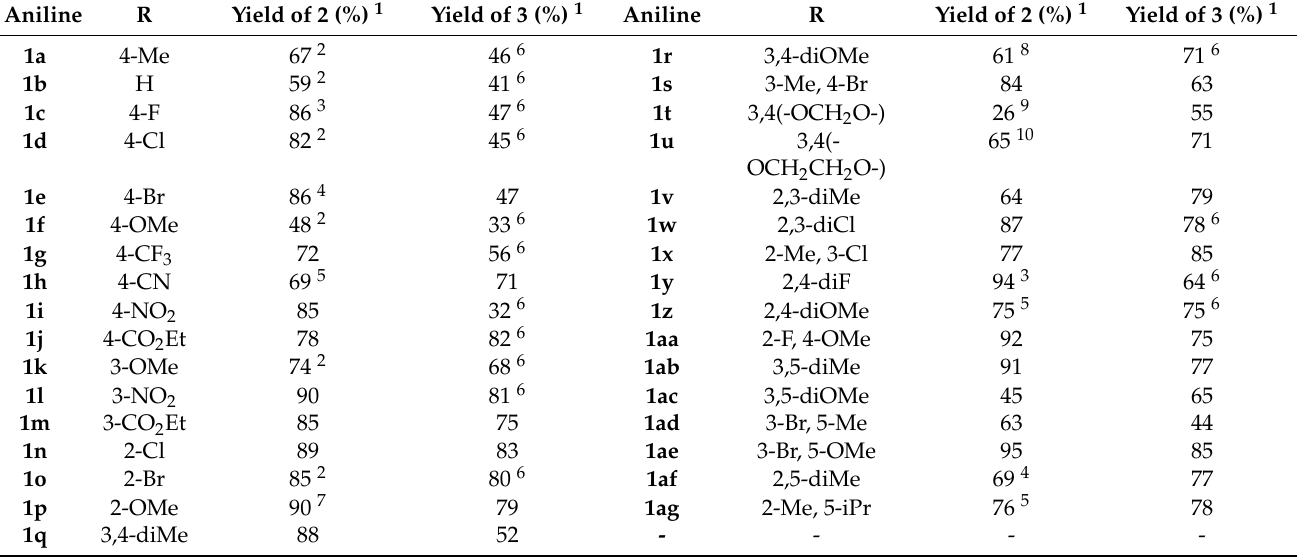
Table 5. Synthesis of dithiazoles 2 and cyanothioformanilides 3 from anilines 1